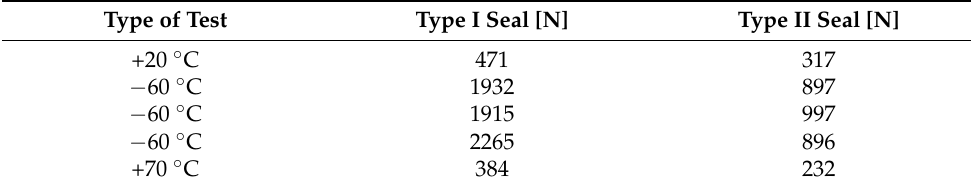
Figure 23. Type I and Type II seals closing forces for the piston with toroidal shape–displacement vs. load. Table 4. Closing force evaluation results were obtained for the piston with a toroidal shape.